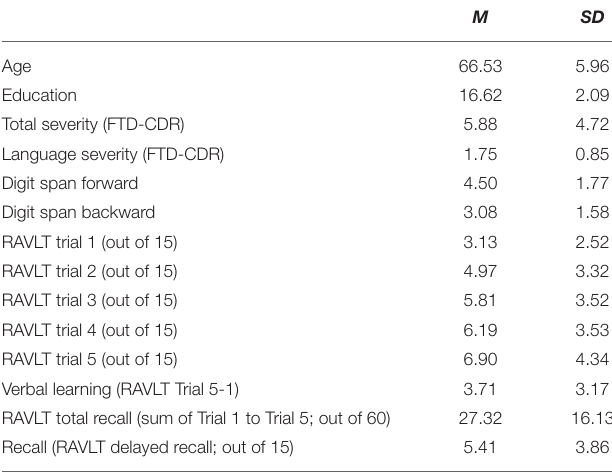
TABLE 1 | Demographic and neuropsychological data of the